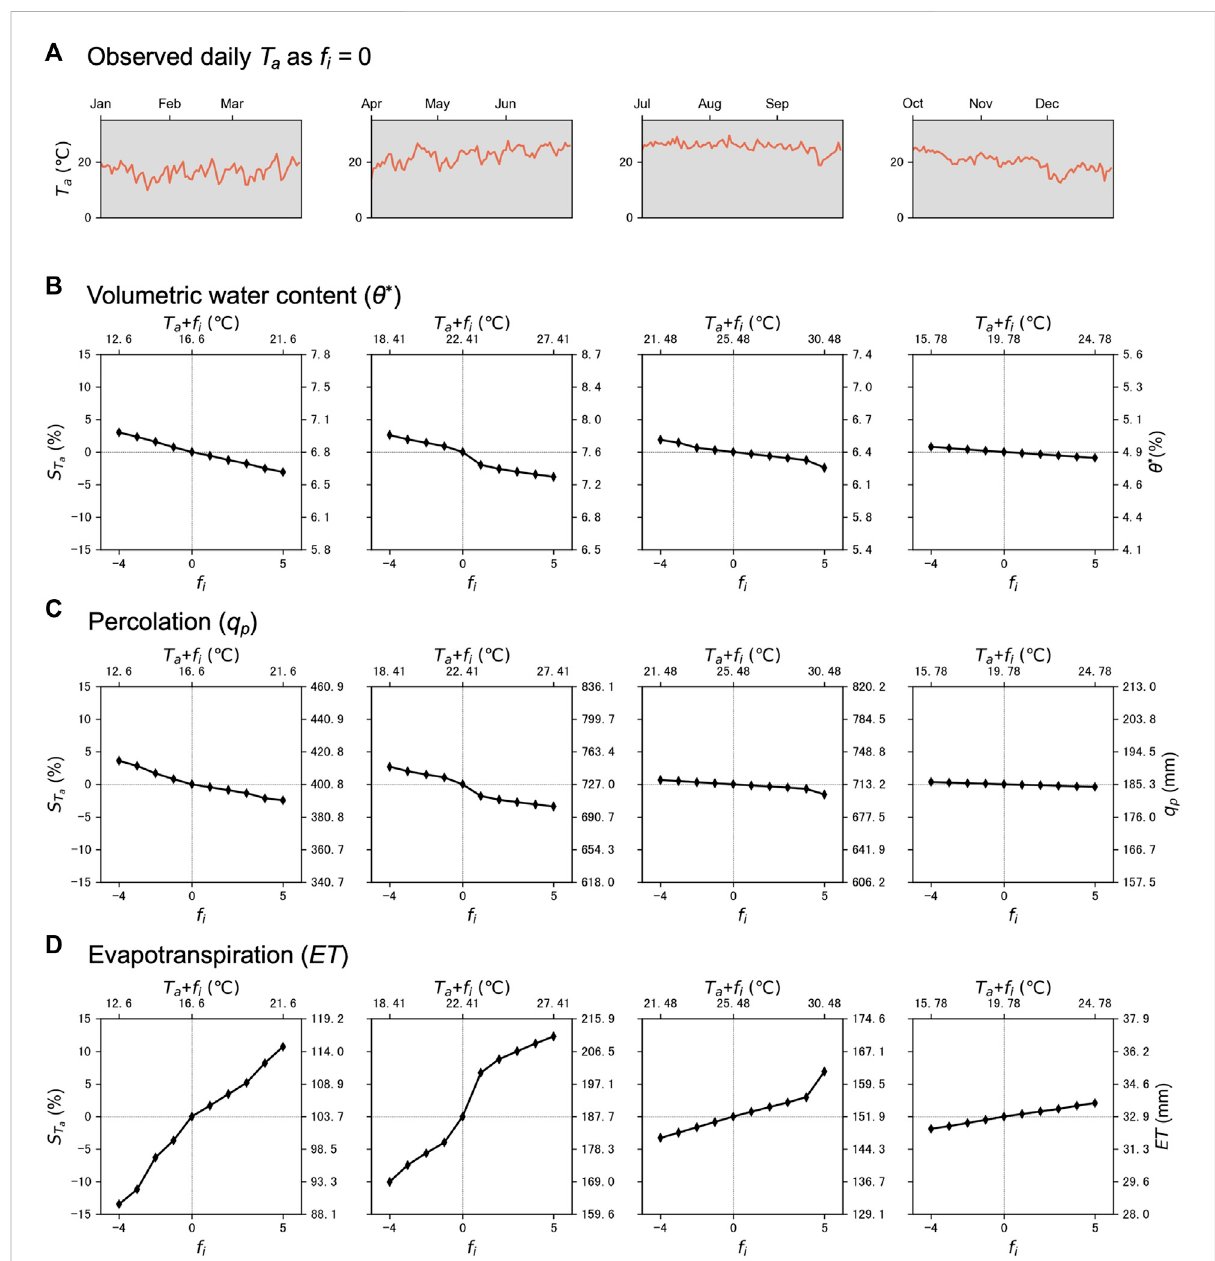
FIGURE 6 Based on (A) the observed daily mean air temperature as f i = 0, we present the sensitivity analysis results of (B) soil moisture content ( θ * ), (C) percolation ( q p ), and (D) evapotranspiration ( ET ) in four periods-- January to March, April to June, July to September, and October to December. In Figures 6B – D, the lower x-axis denotes the fractional change ( f i ), and the upper x-axis represents the range of T a in the sensitivity analysis. The left y-axis represents the sensitivity to air temperature (S Ta ), while the right y-axis indicates the simulated results of the magnitude of the correspondent hydrological